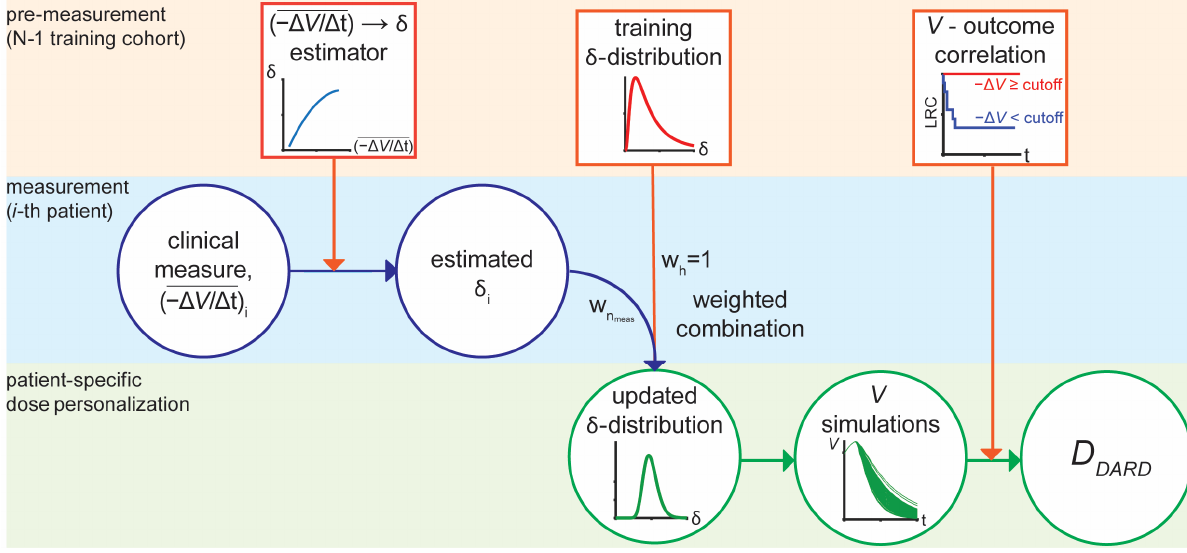
Figure 2. RT Dose personalization framework for D DARD . The framework is divided into three phases: pre-measurement based on the historical cohort, measurements for the i-th patient, and patient-specific dose personalization. The squares represent information learned from the training cohort; circles represent information measured or calculated for an individual patient.